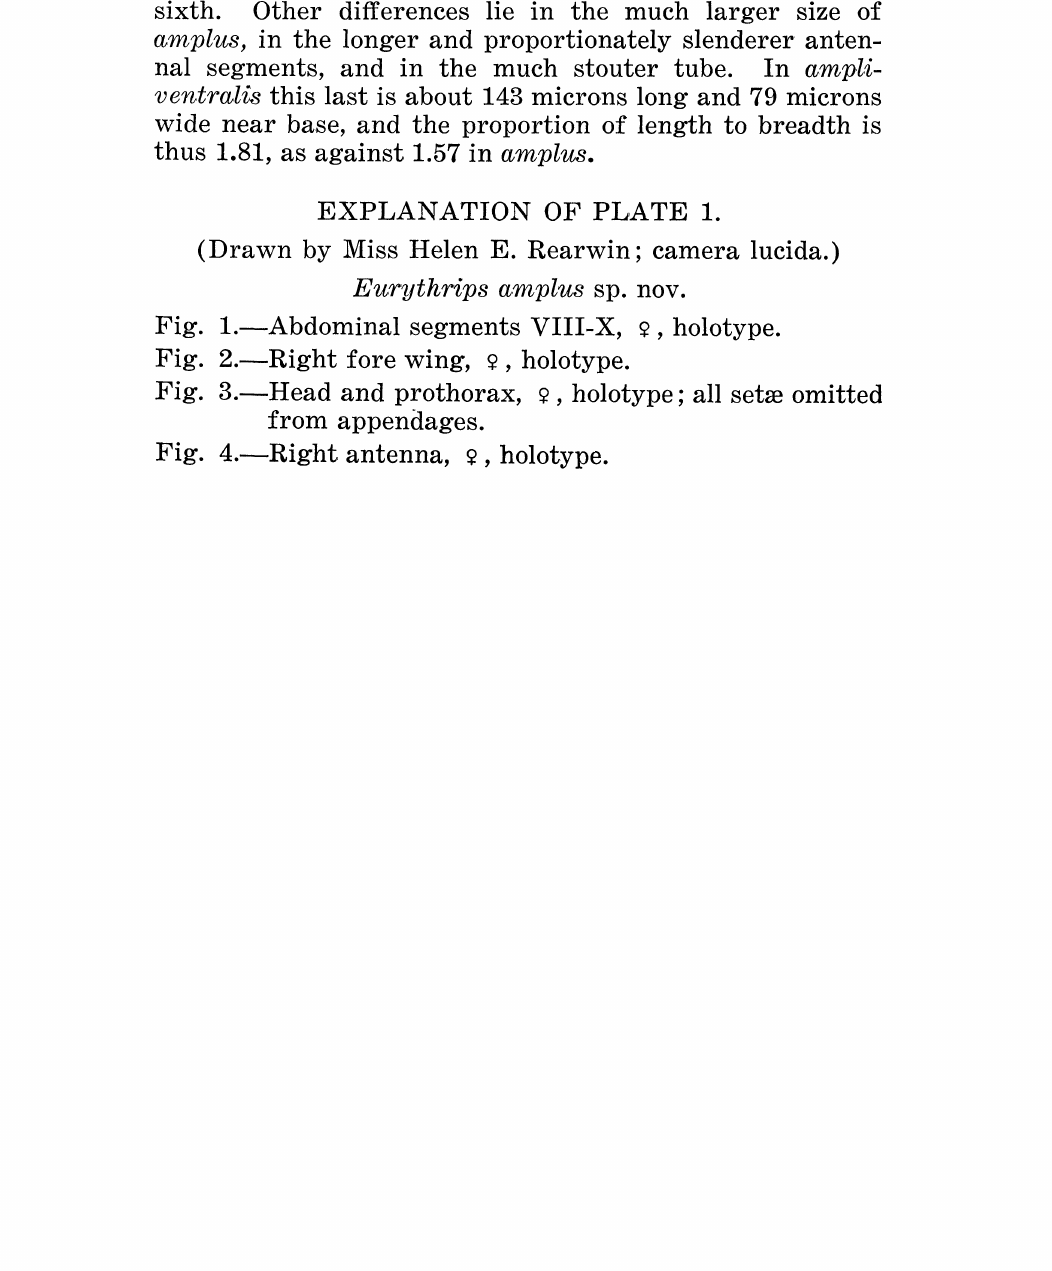
, , Fig. 1.Abdominal segments VIII-X, holotype. , Fig. 2.Right ore wing, holotype. Fig. 3.Head and prothorax, holotype; all sete omitted , 2rom appendages. Fig. 4.--Right antenna,